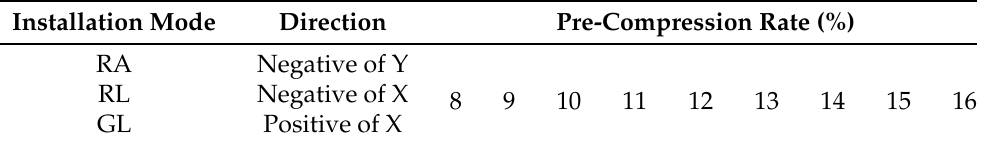
Table A1. Parameters of installation mode experiment.